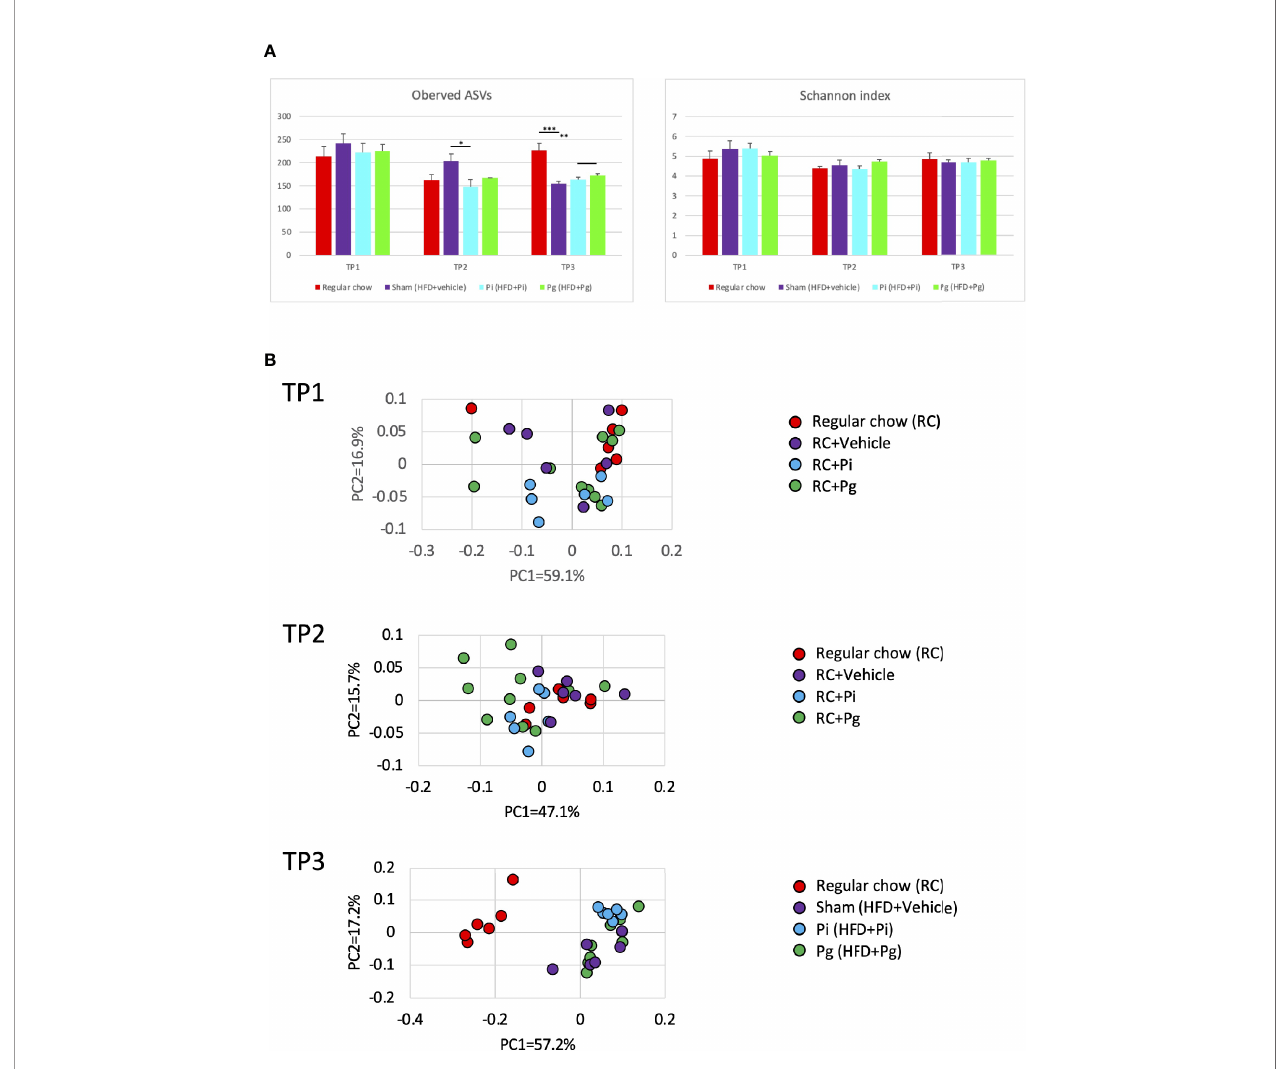
FIGURE 4 | Effect of CDAHFD60 feeding and subsequent bacterial administration on the gut microbiota composition (n=6-10/group). Fecal samples from mice in various treatment groups were subjected to 16S rRNA sequencing. (A) Alpha diversity of each experimental group at different time points. ASV, Amplicon sequence variant. (B) Principal coordinate analysis score plot of the gut microbiota pro fi les of each experimental group at different time points using weighted UniFrac distance. Data are expressed as the mean ± standard error of the mean (SEM). P values were calculated using one-way ANOVA with Tukey ’ s multiple comparisons test. * P <0.05, ** P <0.005, *** P